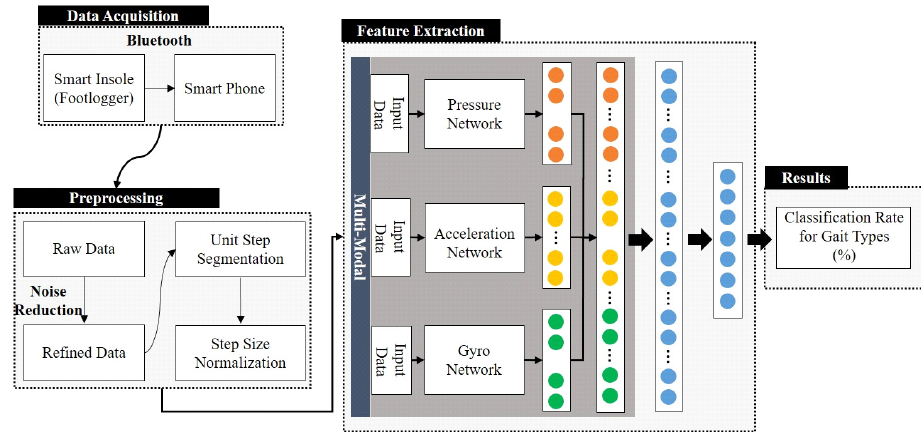
Figure 6. Overall structure of the proposed method to classify gait types (multi-modal